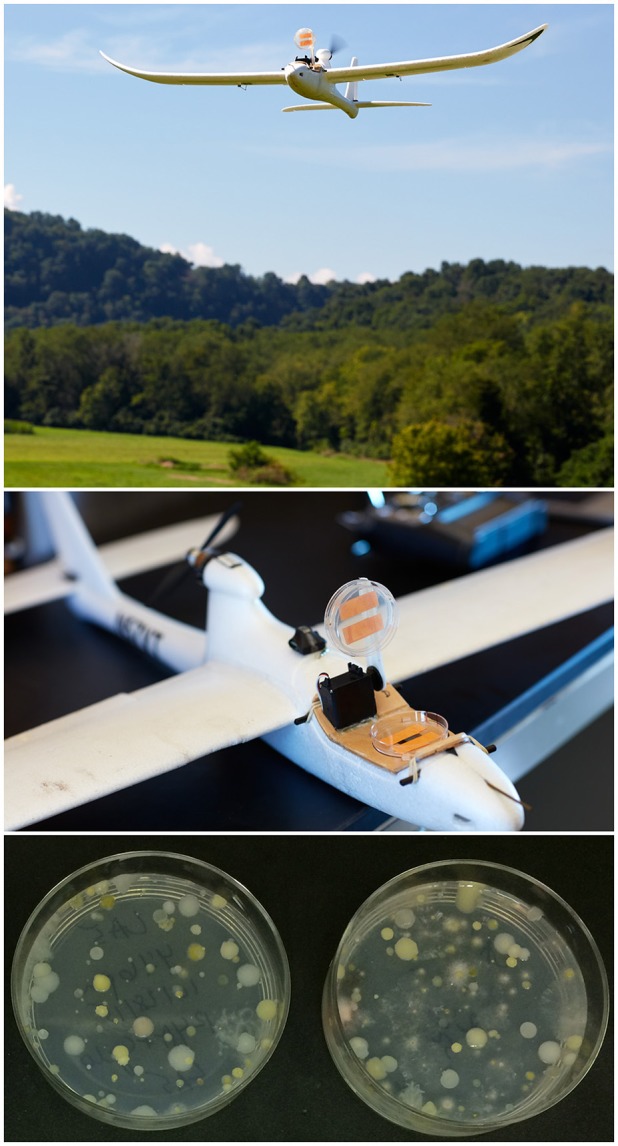
A small unmanned aircraft system (sUAS) was used to collect samples 50 m above ground level. The microbe-sampling device consisted of a single 60 mm vertically-mounted petri plate containing agar media. The sampling device was closed during takeoff and landing, and was opened by remote control from the ground once the sUAS was at the target sampling altitude and airspeed (top and middle panels). The device remained open for the duration of the 10-min sampling interval, and was closed at the end of the sampling interval prior to landing. Immediately following sample collection, the exposed plate containing the agar media was removed from the sampling device and stored in a small plastic container for transport to the laboratory. Plates were incubated for 3–4 days at room temperature, and colony forming units (CFUs) were counted and colonies (bottom panel) were picked and transferred to new media. Left plate was from sUAS mission LA5, and right plate was from sUAS mission LA6.